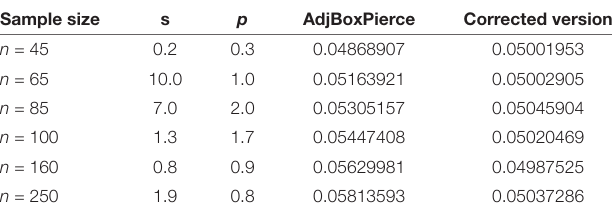
TABLE 1 | Performance summary of the correction to the Adjusted Box-Pierce.